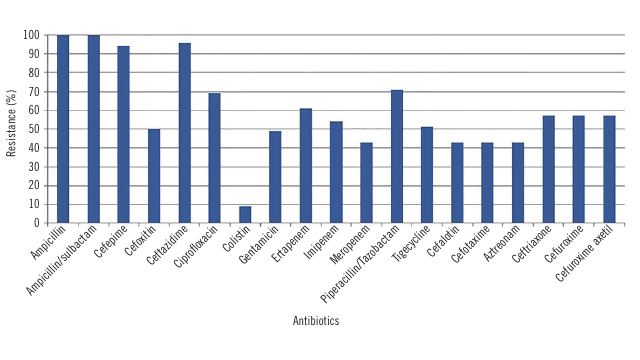
figurE 2 − Antibiotic resistance genes detected in ESBL-producing K. pneumoniae ESBL: extended-spectrum beta-lactamases.